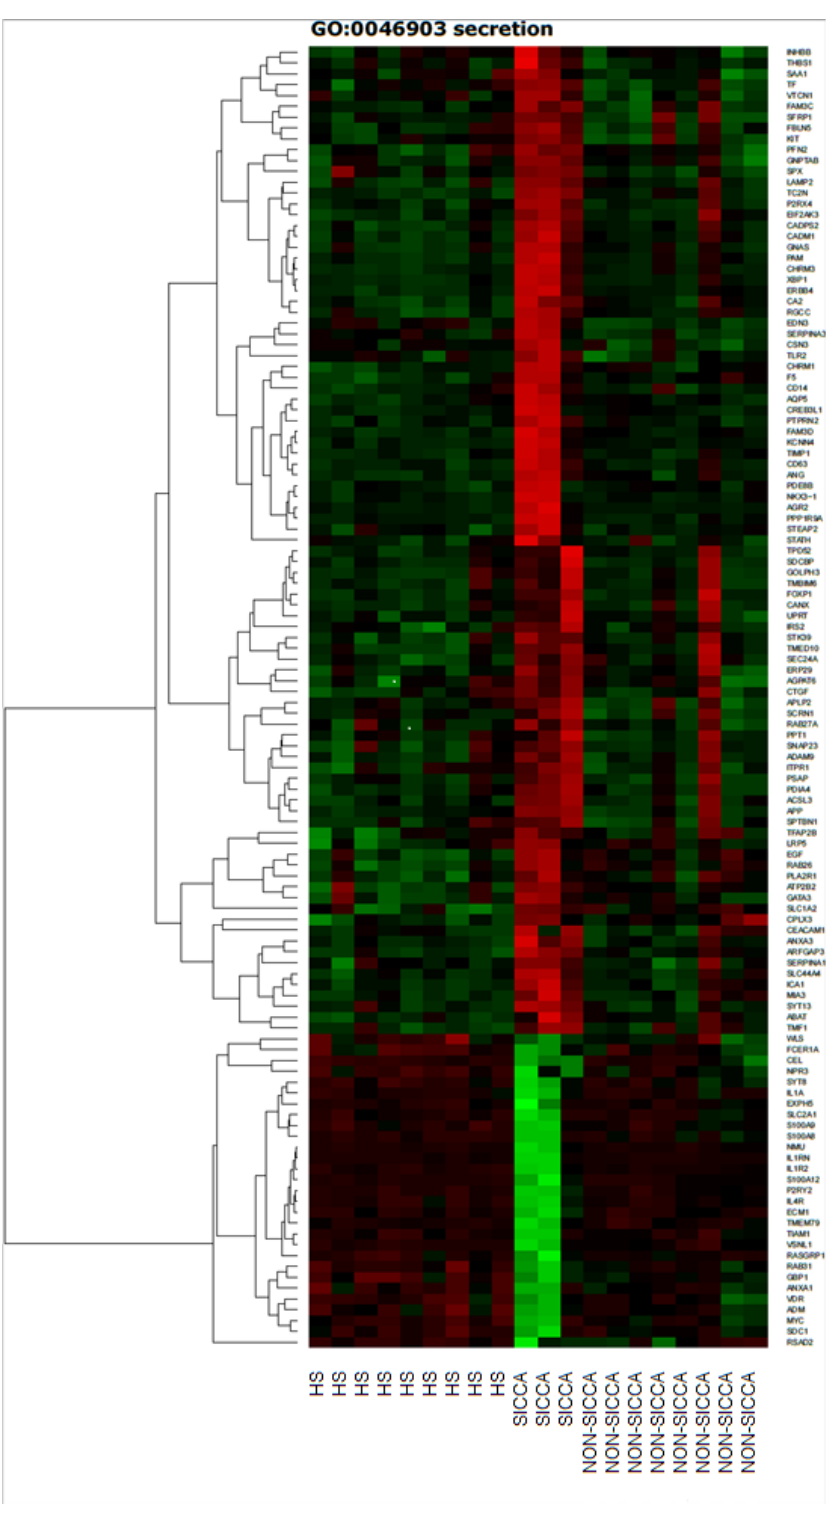
Figure 1. Hierarchical clustering of data from the microarray analysis of gene expression in LSG from patients with SS with (sicca) and without (non-sicca) xerostomia and from the control (HS). Samples with similar patterns of expression of the genes studied will cluster together, as indicated by the dendrogram. Red indicates a higher expression of the gene in SS patients and HS compared to the reference (up-regulated), and green indicates a lower expression of the gene compared to the reference (down-regulation).